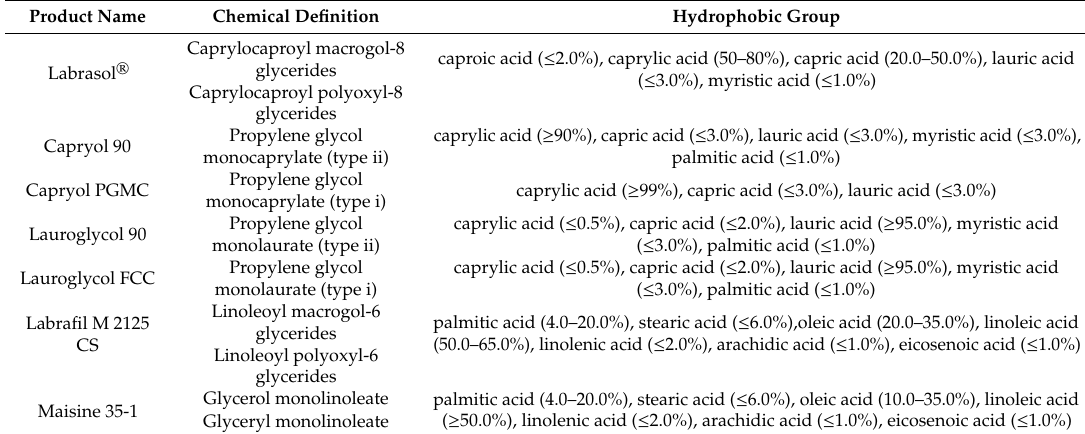
Table 1. Compositions of Labrasol ® and its related